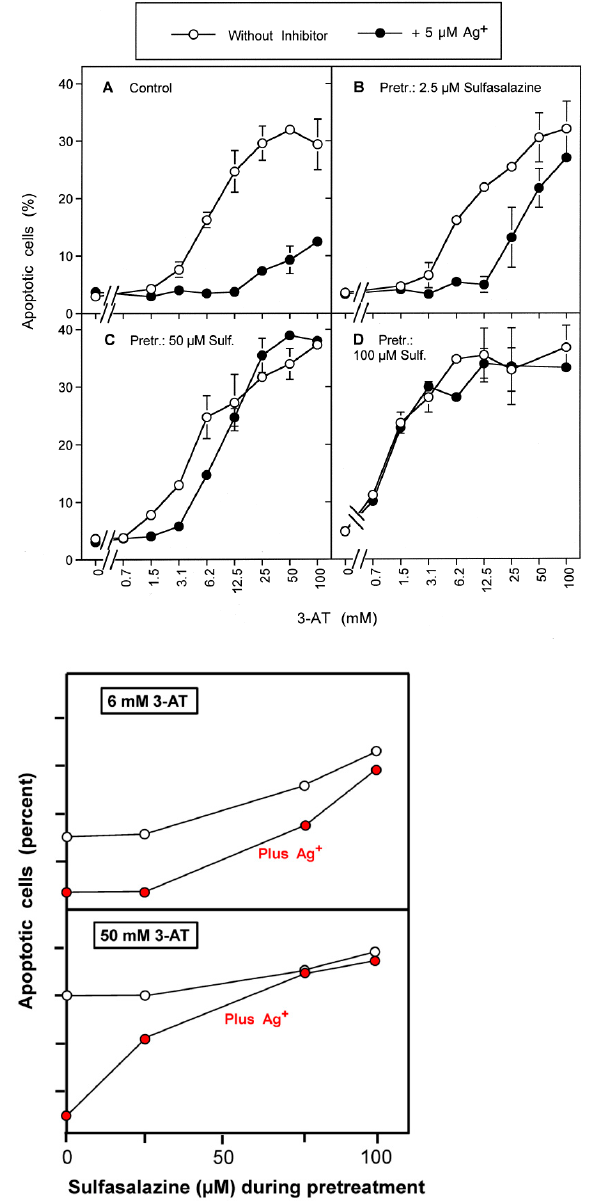
Figure 12. Sulfasalazine pretreatment renders ROS/RNS-dependent apoptosis-inducing signaling independent of the action of aquaporins. MKN-45 cells (200,000 cells/mL) were pretreated for 14 h in the absence of sulfasalazin (control) ( A ) or presence of increasing concentrations of sulfasalazine ( B : 2.5 µM; C : 50 µM; D : 100 µM). After pretreatment, cells were washed and reseeded at a density of 12,500 cells/well in 96 well tissue culture clusters. Assays were kept either without additional inhibitors or in the presence of 5 µM Ag + . The percentages of apoptotic cells were determined after 5 h. The data show that apoptosis induction in control cells was strongly dependent on the action of aquaporins, whereas the preincubation with increasing concentrations of sulfasalazine caused a decreased dependence on aquaporins. Cells that had been pretreated with 100 µM sulfasalazine were completely independent of the action of aquaporins. Statistical analysis. The gradual differences in inhibition by Ag + , depending on the concentration of sulfasalazine during pretreatment were highly significant ( p < 0.001). The scheme to Figure 12 summarizes that sulfasalazine pretreatment renders 3-AT-mediated apoptosis induction independent of the action of aquaporins. This effect is dependent on the concentration of sulfasalazine during pretreatment. The scheme also indicates that apoptosis induction mediated by 6 mM 3-AT is significantly enhanced by sulfasalazine